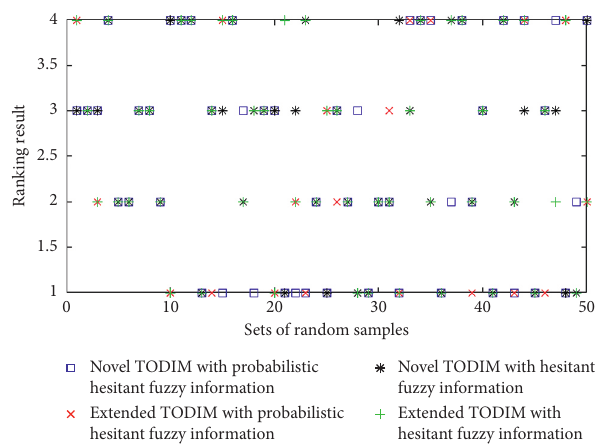
Figure 11: Ranking results of the alternative A samples).